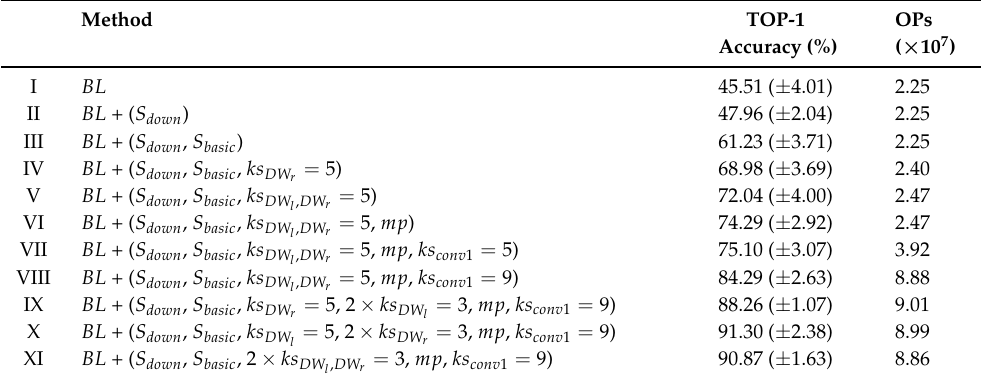
Table 5. The effects of different components in Bi-ShuffleNet on the final accuracy of the Magnetic Tile dataset.